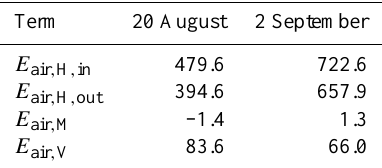
Table 5. Mass-balance terms for air (Eq. 2) in units of 10 9 kgh − 1 . Horizontal advective flux is separated into inward and outward as E air , H = E air , H , out − E air , H , in .